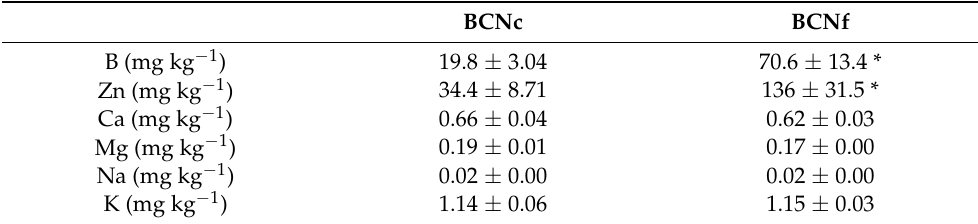
Table 3. Average chemical values ( ± standard error) in foliar samples of hazelnuts from cv Barcelona (BCNc and BCNf).